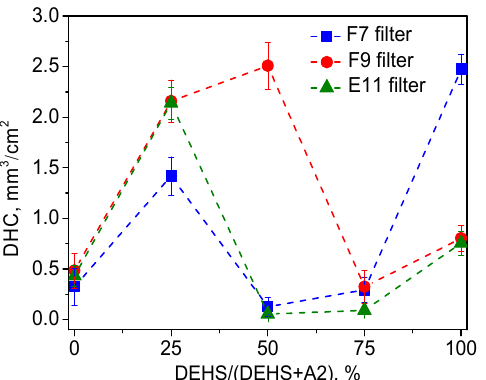
Figure 7. The DHC of the F7 cellulose, F9 melt-blown, and E11 membrane-coated filters loaded with different oil-coated particles.